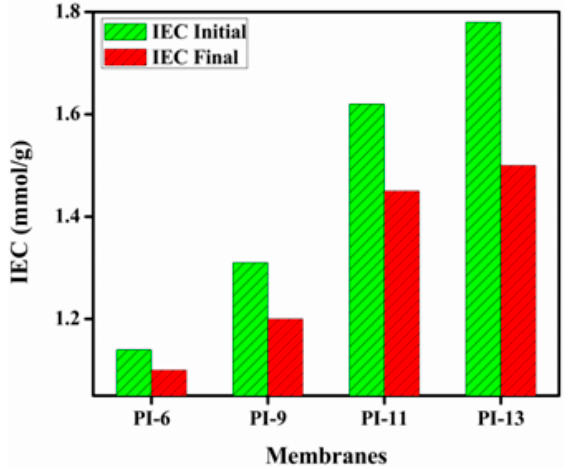
Figure 5. Change in IEC of AEMs after immersion in 2 M HCl for 72 h at room temperature.